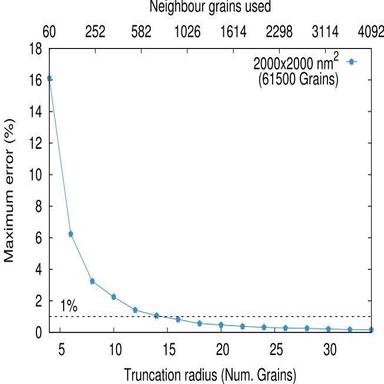
Error in the determination of the magnetostatic field when using the truncation method as a function of the truncation radius.